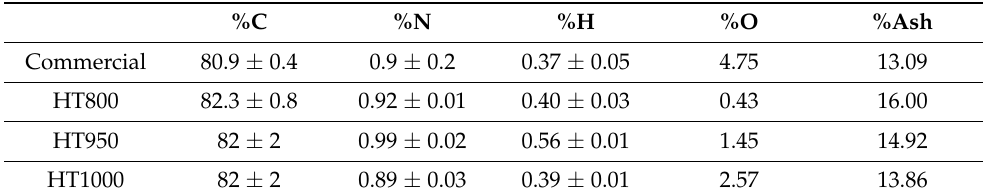
Table 7. Summary of ultimate analysis of activated